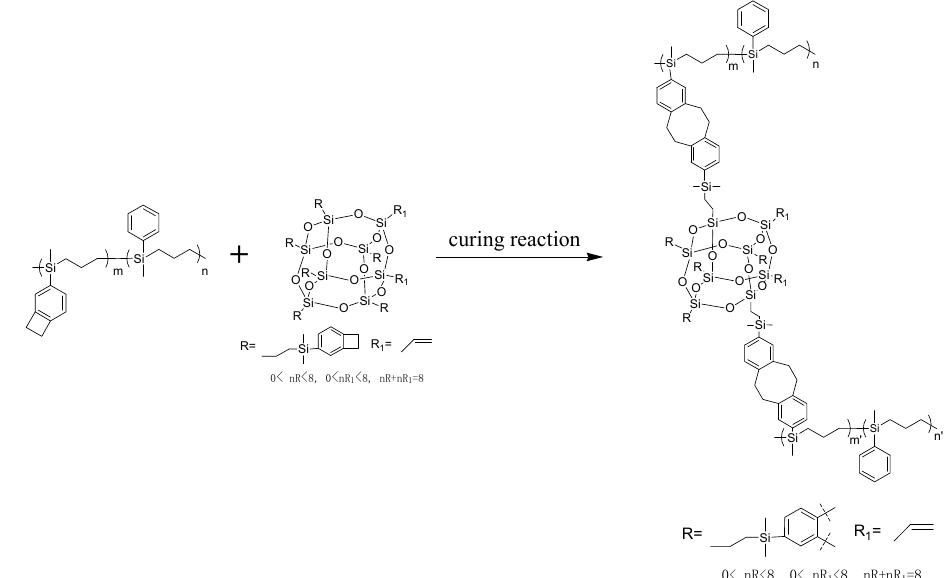
Materials 2021 , 14 , x FOR PEER REVIEW Scheme 2. Schematic diagram of the thermal curing mechanism of P(4-MB-co-1-MP)/BCB-POSS. As shown in Figure 1c, the exothermic peaks of DSC curves of P(4-MB-co-1-